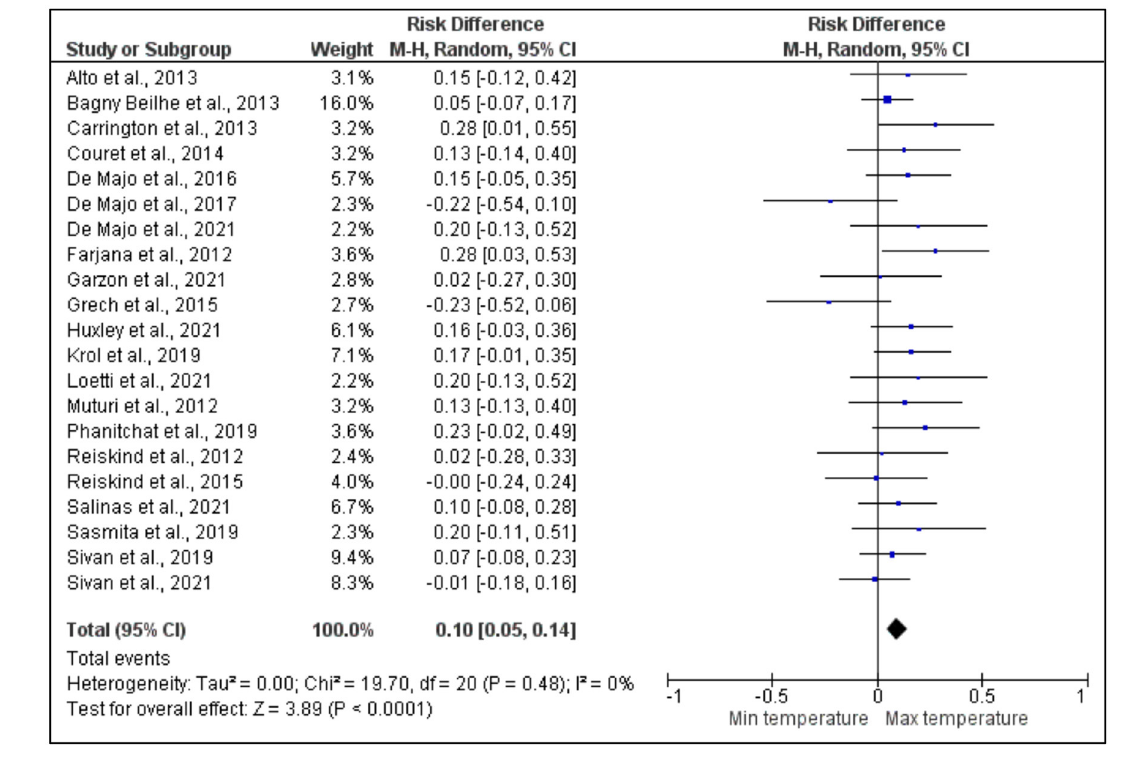
FIGURE6 Forest plot of comparison of the effect of minimum temperature vs. maximum temperature on the survival of dengue vectors.